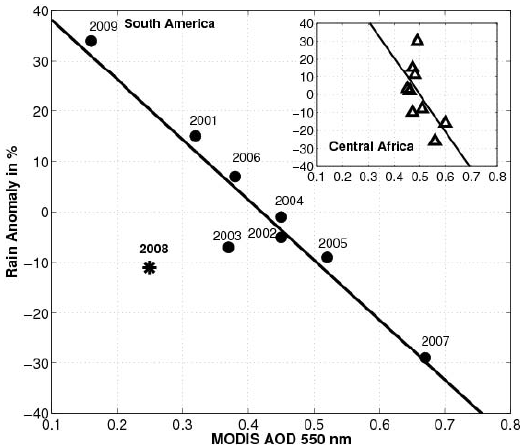
Fig. 6. Observed relationship between rainfall anomaly and atmo- spheric aerosol load.